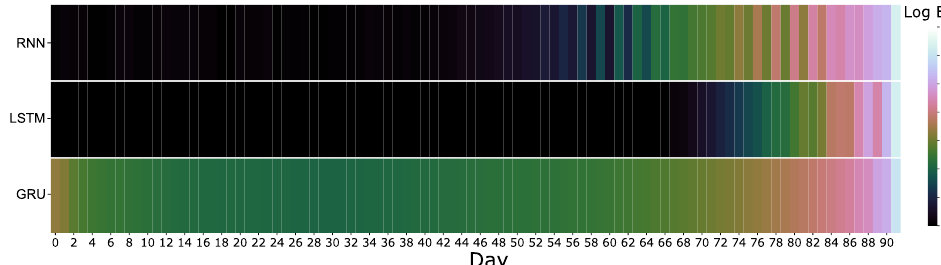
Figure 6. The log error introduced after adding 1% of noise at each